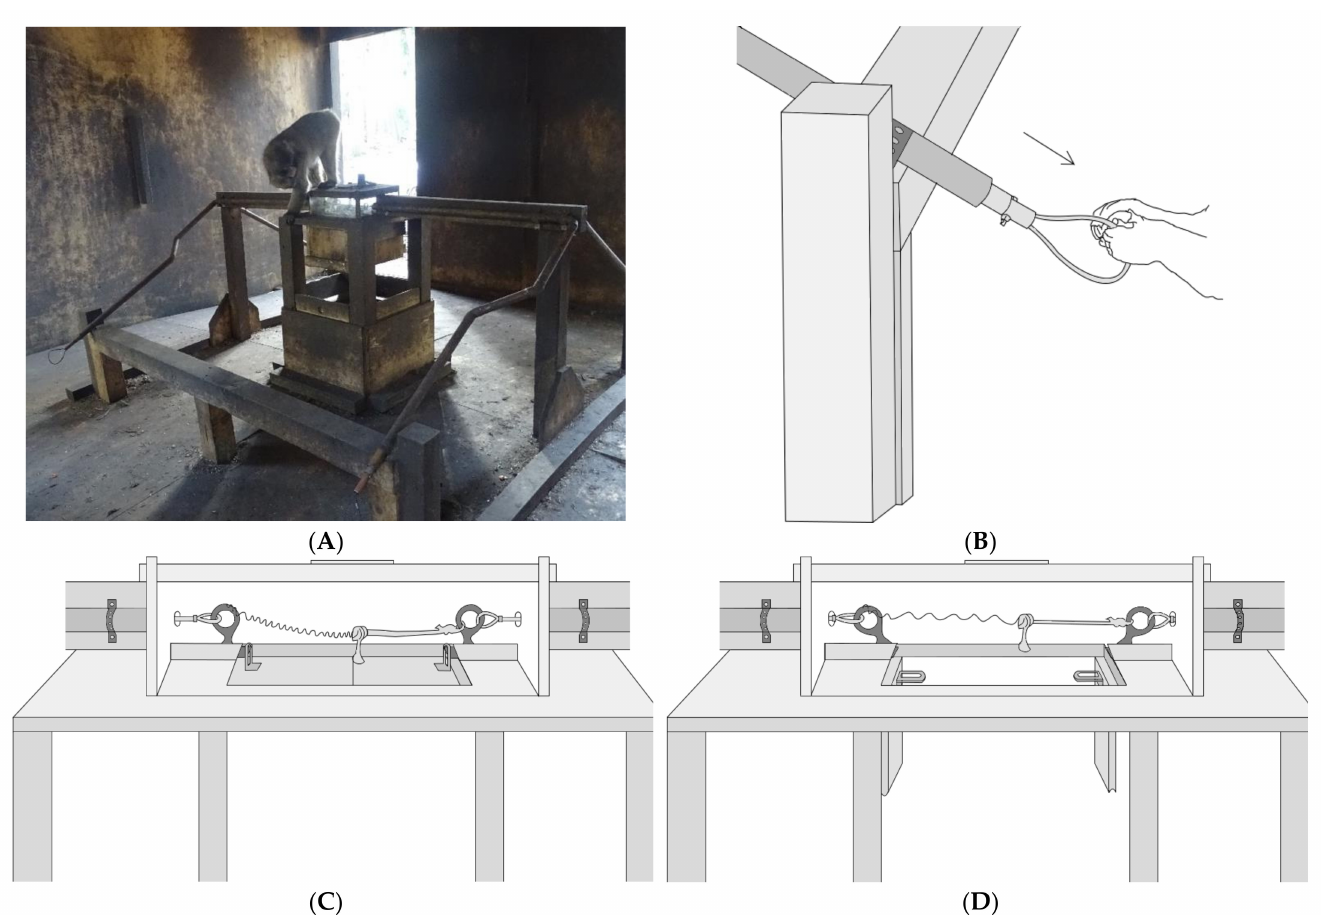
Figure 1. ( A ) Photo of the apparatus used in the study. Food rewards remain visible but inaccessible in the plexiglass lockbox until simultaneous pulling of the loops positioned at the end of the copper pipes triggers the opening of the trapdoor, allowing the rewards to fall onto the platform below. ( B ) Close-up illustration of one of the loops. ( C ) Close-up illustration of the lockbox in the closed position. A latch mechanism holds the trapdoor in place until both loops are pulled simultaneously, releasing the latch mechanism and allowing the trapdoor to fall open. ( D ) Close-up illustration of the lockbox in the open position. The trapdoor has fallen open after release of the latch